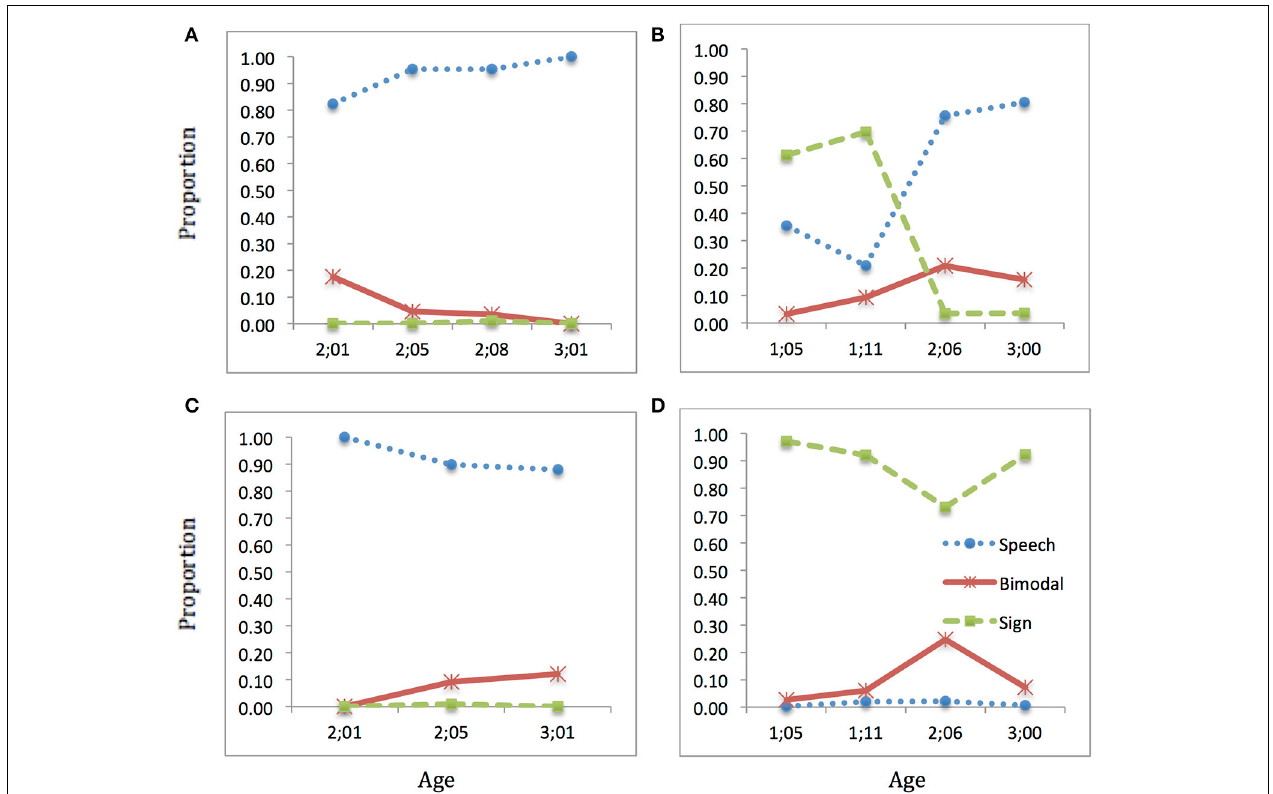
FIGURE 6 | Language choice over time: TOM. Proportion of speech (blue dotted), sign (green dashed), and bimodal (red solid) utterances produced: (A) child speech target; (B) child sign target; (C) interlocutor(s) speech target; (D) interlocutor(s) sign target (Note: Intervals along x-axis are not